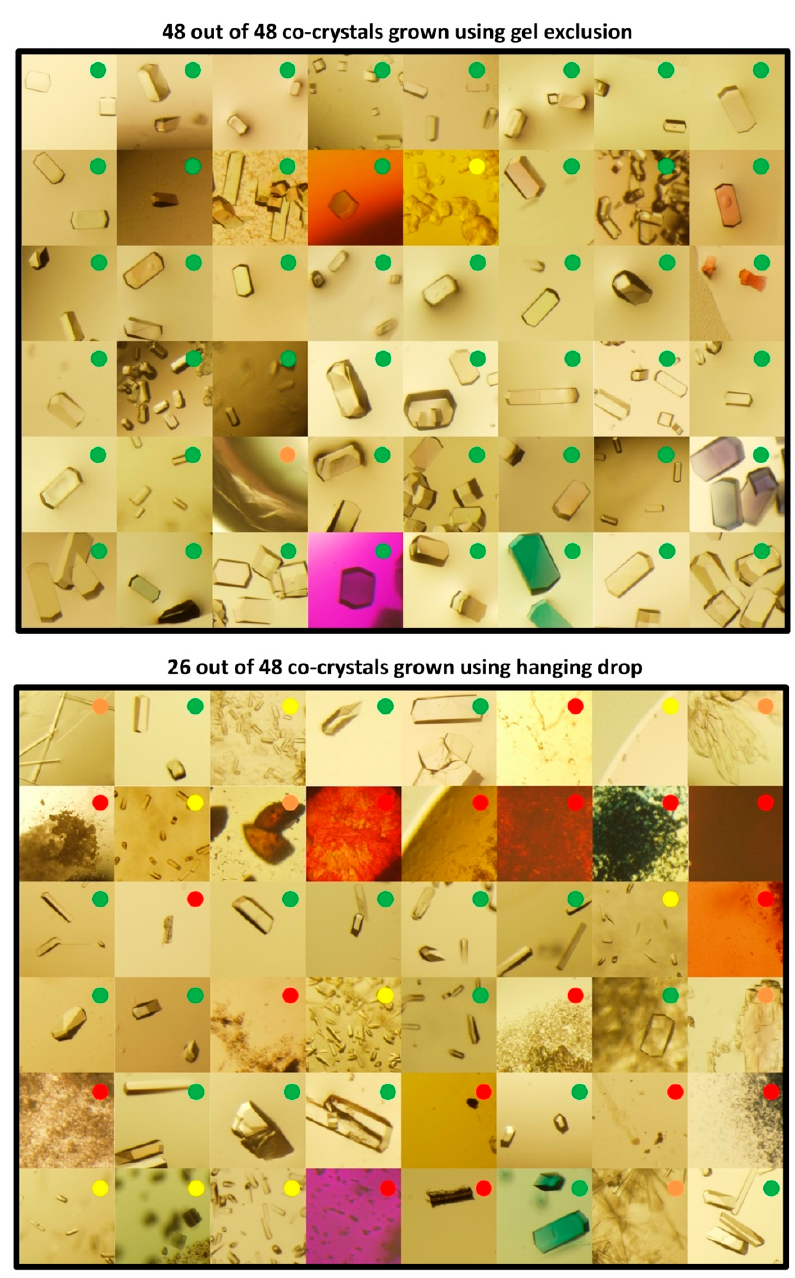
Figure 5. Co-crystallization of lysozyme with 48 fragments (gel exclusion on left, control on right). Green dots indicate large crystals, yellow dots indicate small crystals, orange dots indicate possible crystals, and red dots indicate no crystals). Gel exclusion co-crystallization yielded 48 crystals out of 48 screens, compared to 26 using conventional hanging drop (detailed description of fragment library in Supplementary materials section